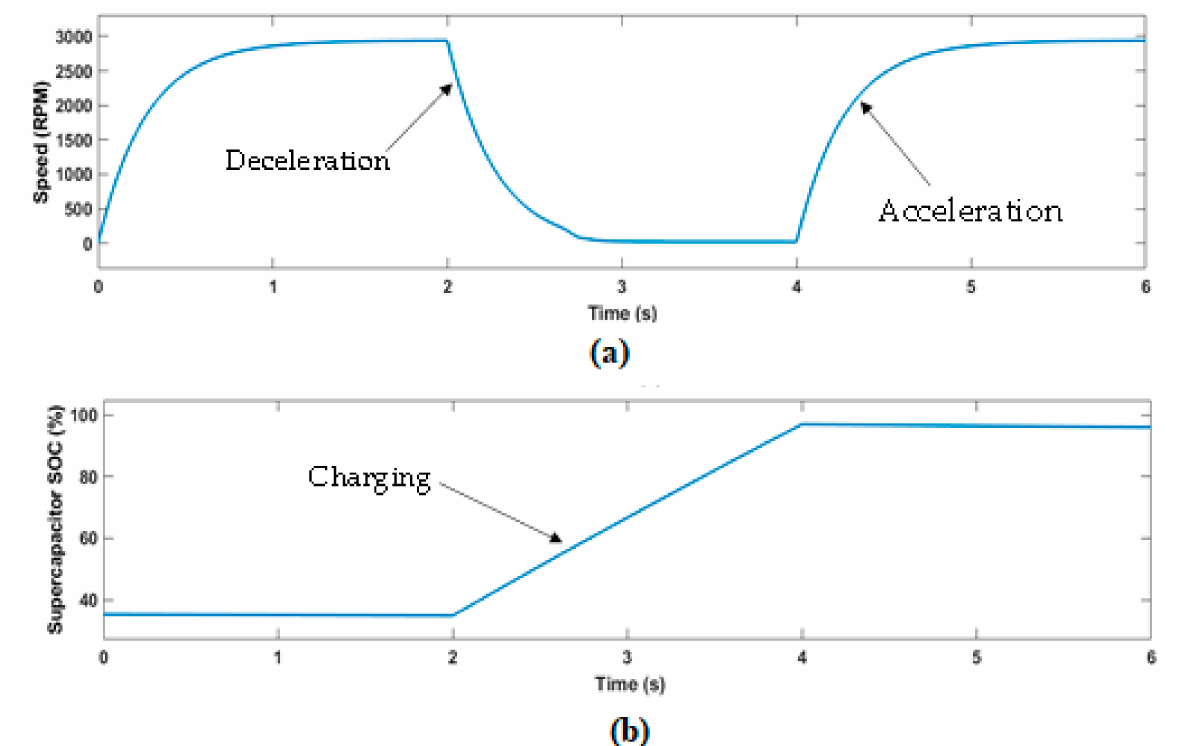
Figure 29. ( a ) Acceleration and deceleration of speed at Scenario 3 ( b ) SOC of